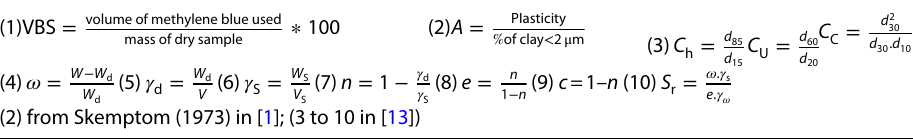
Table 2 Geotechnical parameters (1) VBS =